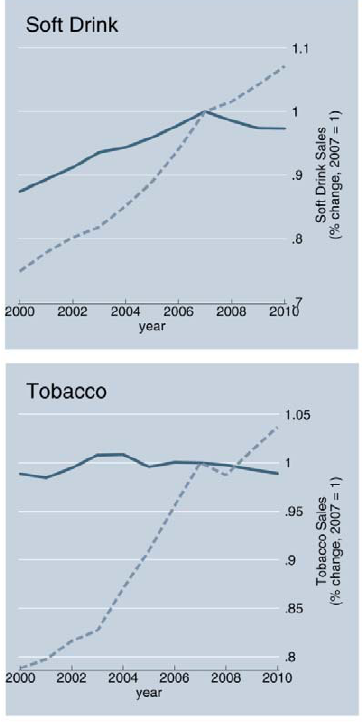
Figure 1. Growth of Big Food and Big Tobacco sales in developing countries: An example. Shaded blue line is developed countries, dashed grey line is developing countries. Source: Passport Global Market Information Database: EuroMonitor Interna- tional, 2011 [12].